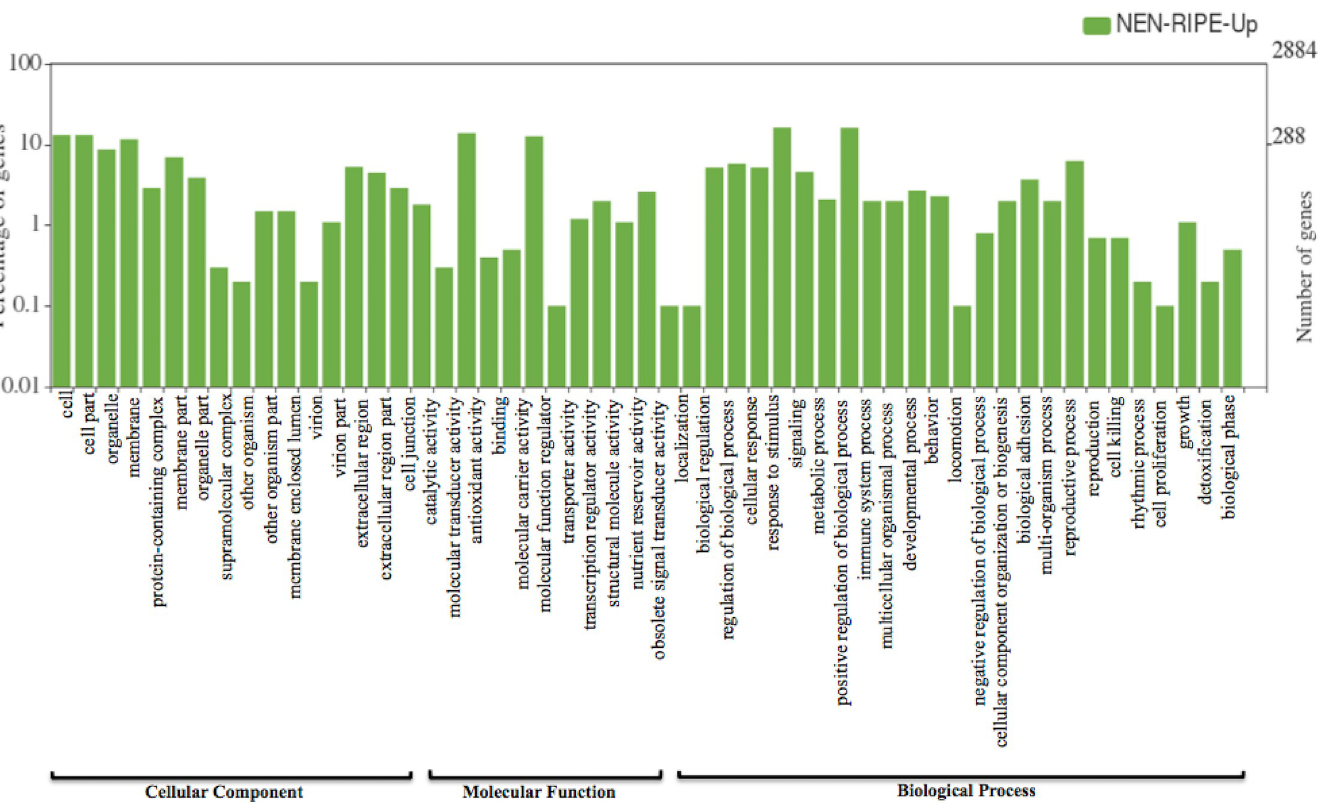
Fig 2. WEGO plot representing annotation and classification of differentially expressed genes in Nendran ripe fruit-pulp. X-axis (right) displaying selected GO terms of up-regulated genes and y-axis (left) displaying the percentage of genes.